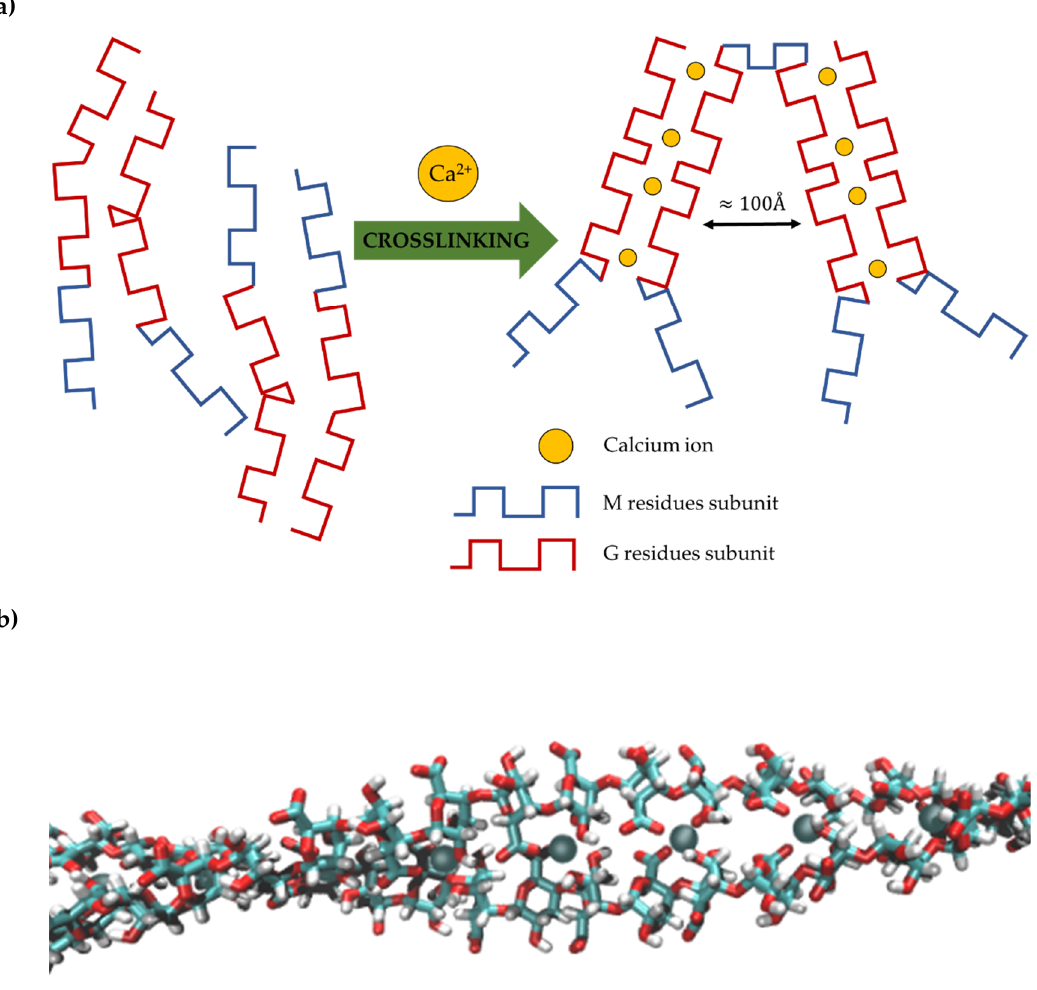
Figure 1. ( a ) Schematic representation of calcium ion mediated cross-linking mechanism of alginate strands. The calcium ions form a coordinative bond between G residues forming large pores (approximately 100 Å according to [54]) between cross-linked strands; ( b ) molecular model of alginate-Ca 2 + hydrogel. Green indicates carbon atoms; red, oxygen; white, hydrogen; grey balls between alginate strands, calcium ions.